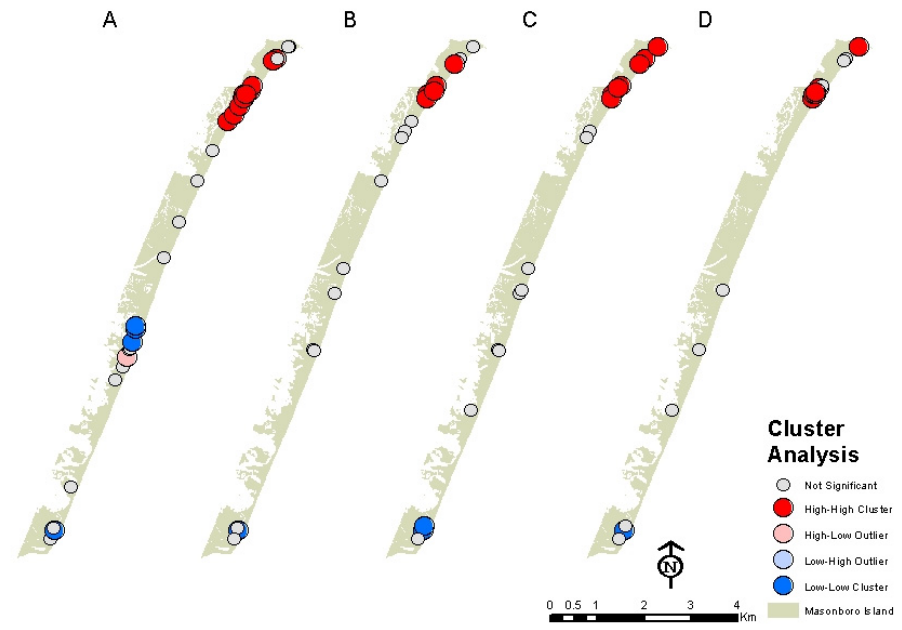
Figure 8. Results from the local Moran’s I cluster analysis using mean elevation at each den entrance location: ( A ) 2009, ( B ) 2010, ( C ) 2011, and ( D ) 2012.